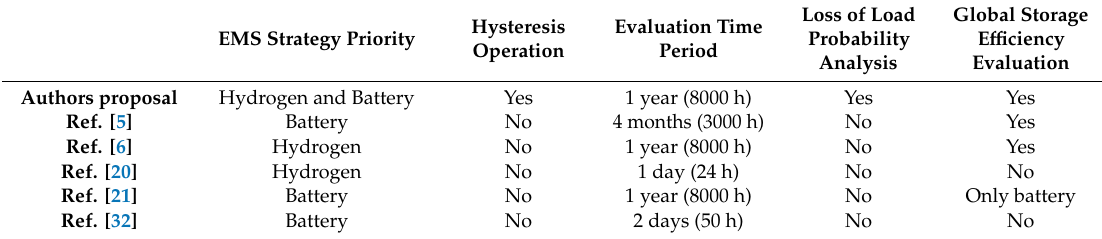
Table 7. Comparison of the findings of the proposed paper with previous